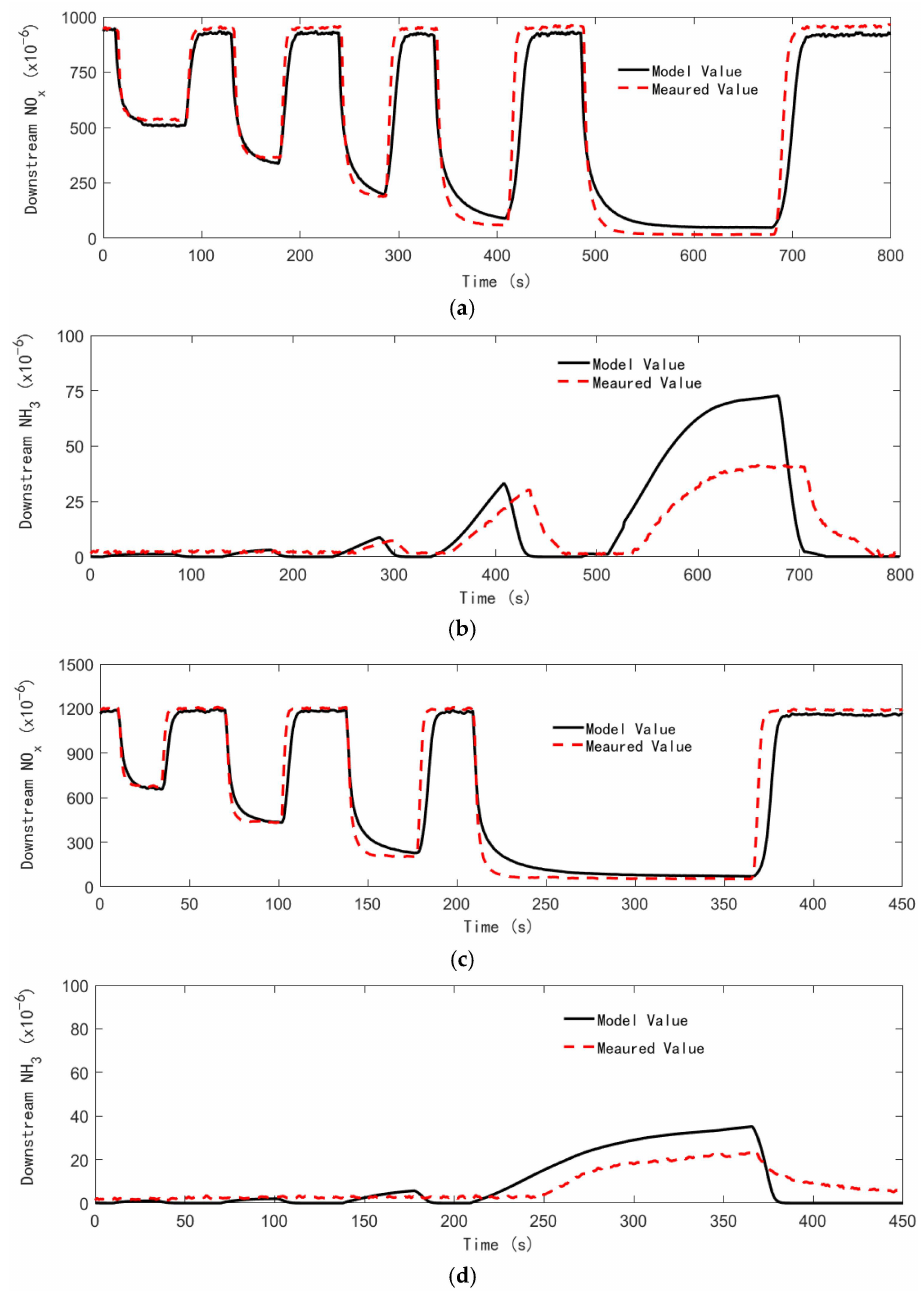
Figure 8. NO x and NH 3 comparison curve between the model calculated value and the measured value. ( a ) Downstream NO x when catalyst temperature is 330 ◦ C; ( b ) downstream NH 3 when catalyst temperature is 330 ◦ C; ( c ) downstream NO x when catalyst temperature is 370 ◦ C; ( d ) downstream NH 3 when catalyst temperature is 370 ◦